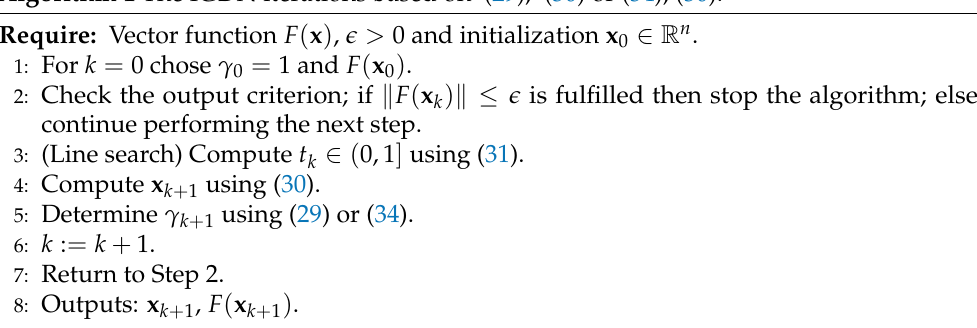
Algorithm 1 The IGDN iterations based on (29), (30) or (34),